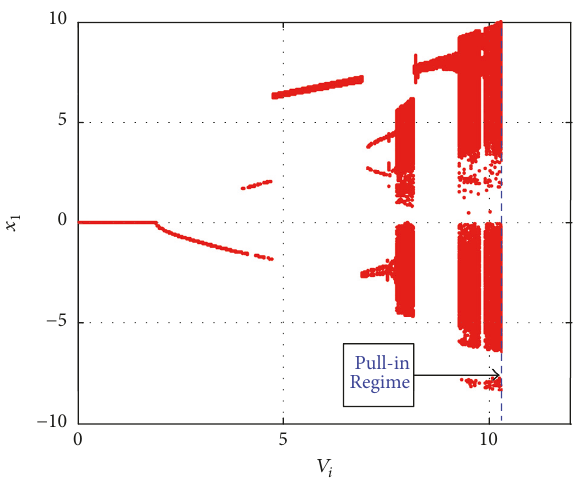
Figure 6: Bifurcation diagram with